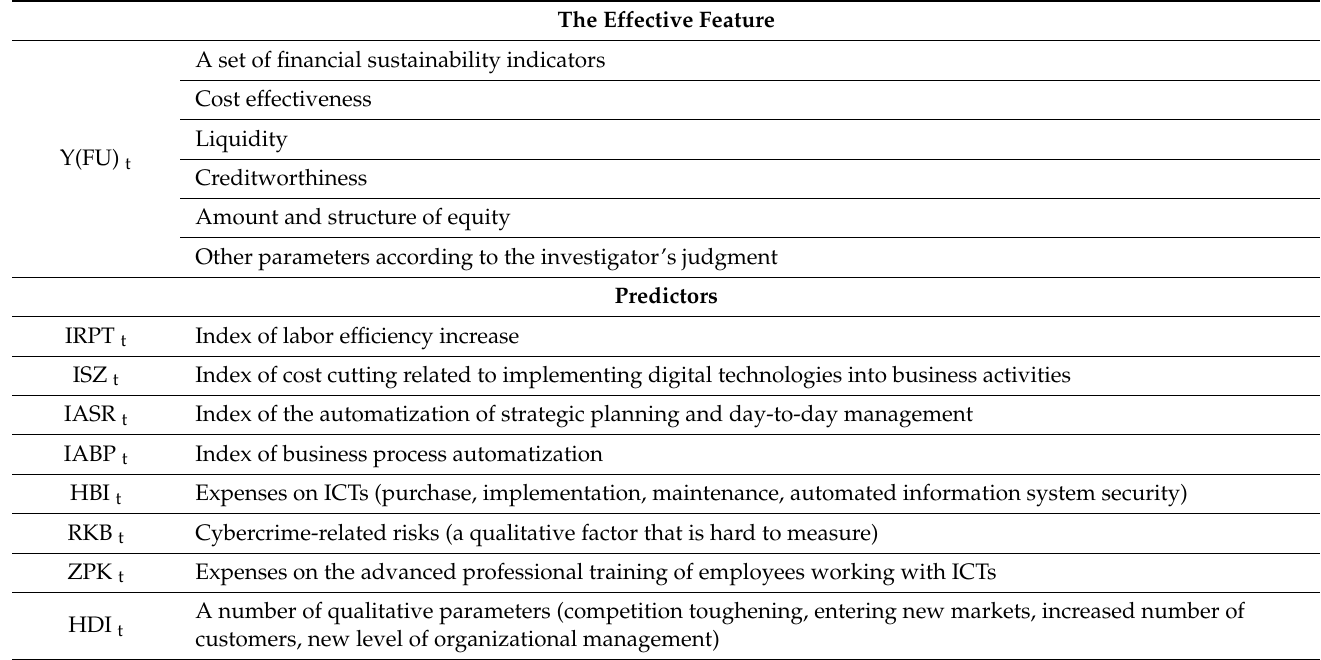
Table 2. Parameters to be chosen for the regression model.